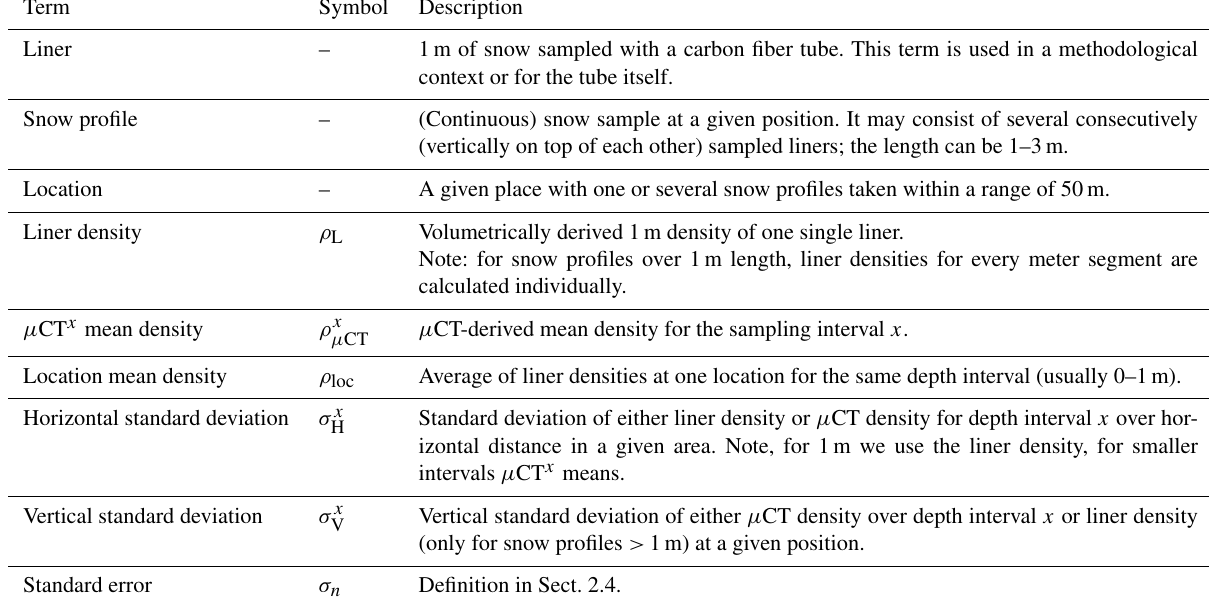
Table 1. Definition of terms used in the following sections are listed below. Term